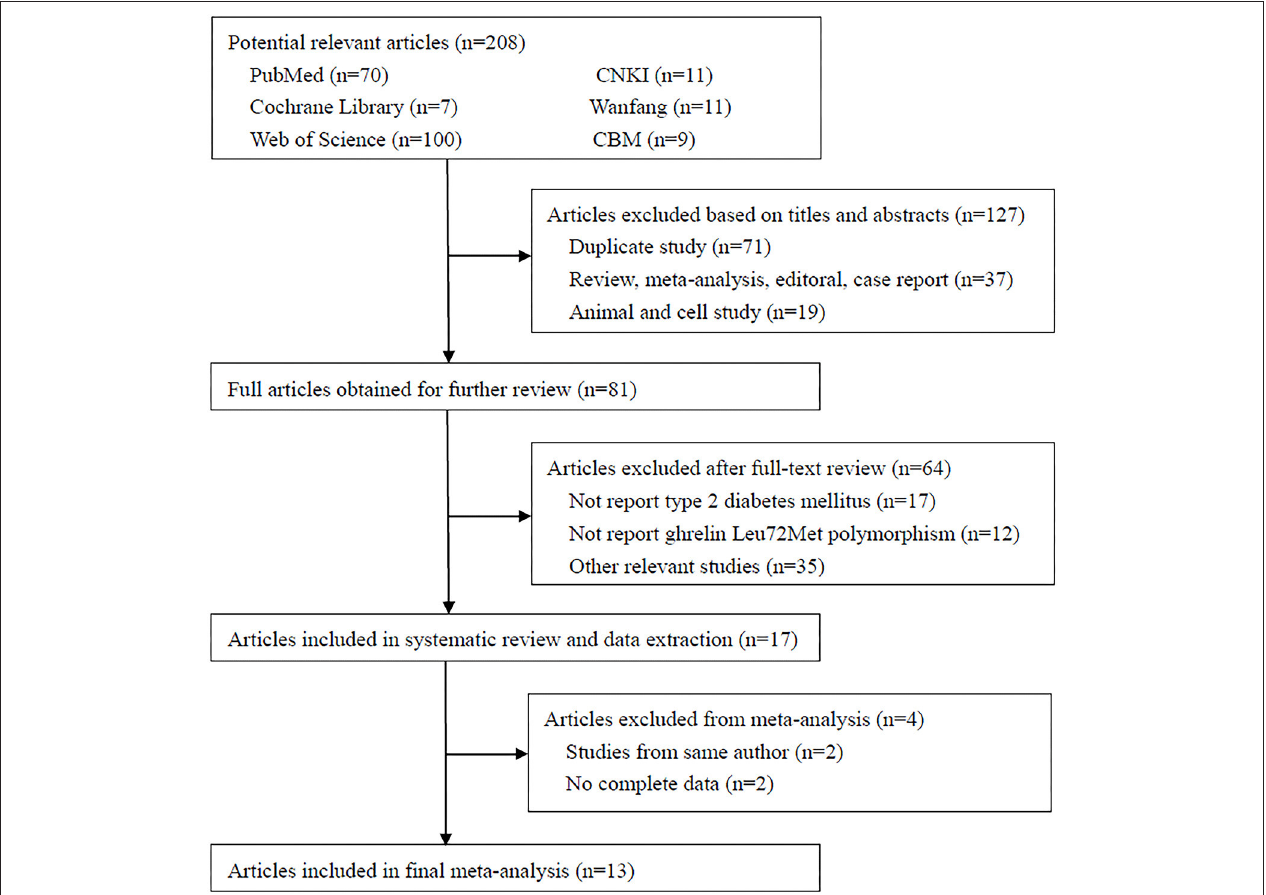
FIGURE 2 | Flow chart of literature